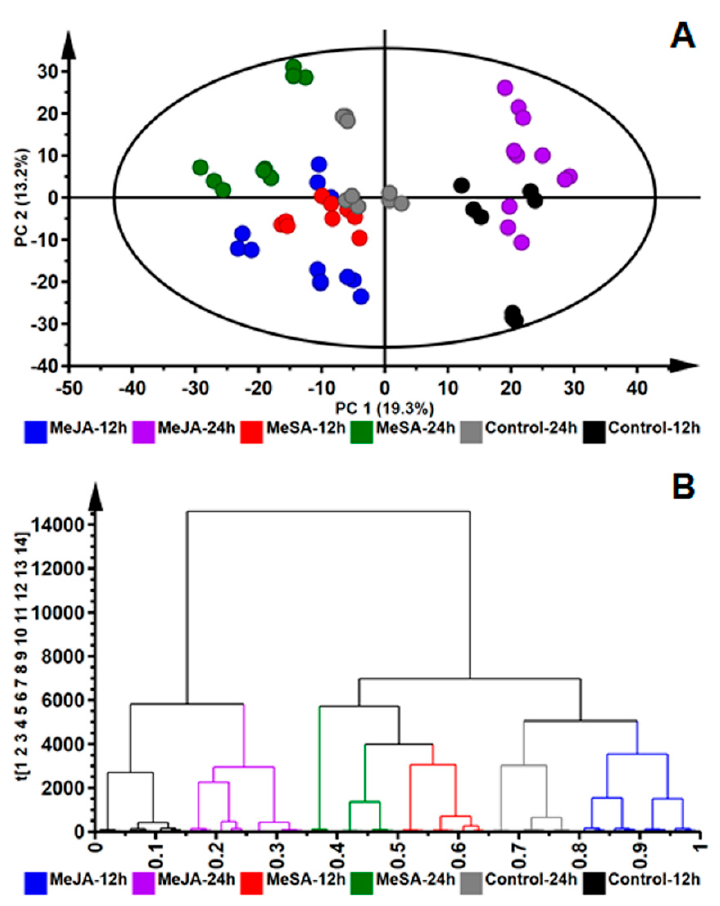
Figure 2. Unsupervised exploratory statistical analysis of Bidens pilosa leaf tissues infiltrated with 0.5 mM MeJA and MeSA and the non-treated control samples at 12 h and 24 h time points: ( A ) a principal components (PC) scores scatter plot of the Pareto -scaled data set. PC 1 and PC 2 of the 14-component model explained 32.5% of the variation. The quality parameters of the model were: explained variation / goodness of fit R 2 = 0.781 and the predictive variance Q 2 = 0.546. The ellipse indicates Hotelling’s T 2 at 95% confidence interval. ( B ) The hierarchical cluster (HC) analysis plot shows the hierarchical structure of the data in a dendrogram format, showing treatment-specific clustering.